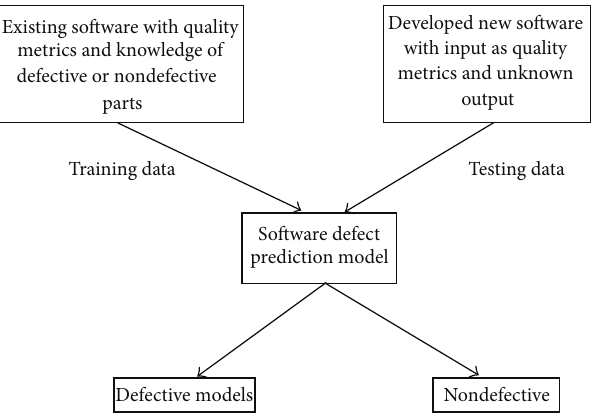
Figure 1: Basic software defect prediction